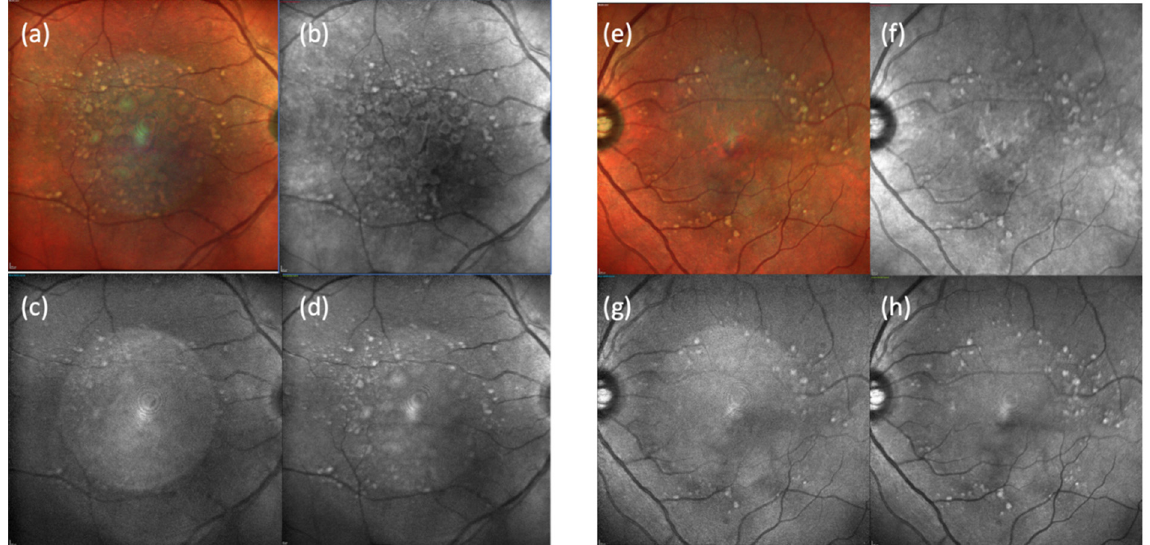
Figure 2. SPECTRALIS ® Heidelberg multicolor ( a , e ) and fundus autofluorescence with near-infrared ( b , f ), blue ( c , g ), and green ( d , h ) reflectance taken one year prior showed focal areas of hyperfluores- cence corresponding to diffuse drusen in both eyes. Multicolor and autofluorescence images were not available for the current